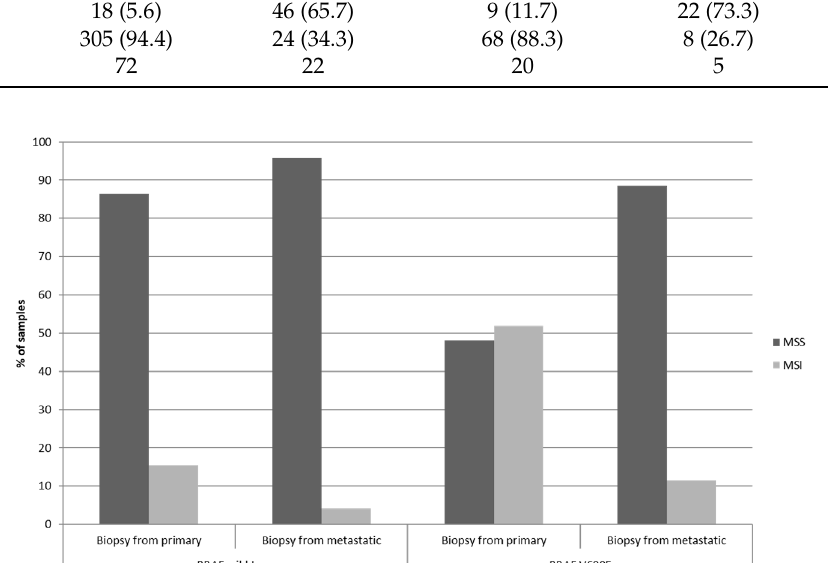
Figure 1. Prevalence of MSI in colorectal cancer biopsies from the primary tumor or from metastatic sites depending on the presence of BRAF V600E mutations. Data are from the MSKCC cohort in which all patients had metastatic colorectal cancer. Samples with non-V600E BRAF mutations were excluded from this analysis. MSI: Microsatellite Instability high; MSS: Microsatellite Stable.